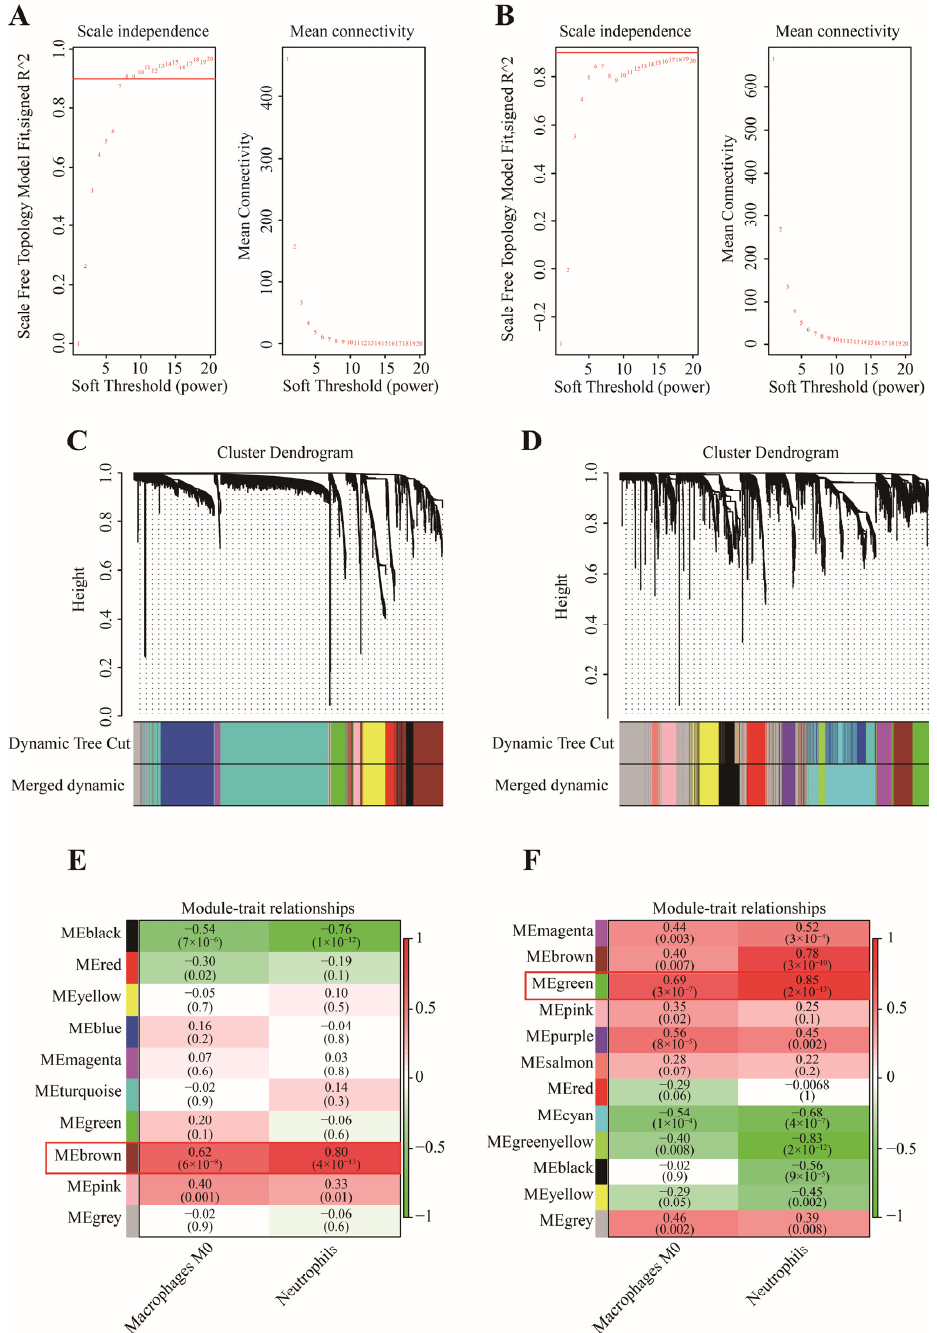
Figure 5. The selection of key modules associated with important immune cells. ( A ) The scale inde- pendence and mean connectivity in GSE152641. ( B ) The scale independence and mean connectivity in GSE171110. ( C ) The cluster dendrogram in GSE152641. ( D ) The cluster dendrogram in GSE171110. ( E ) The heatmap of correlation between modules and two important immune cells in GSE152641. ( F ) The heatmap of correlation between modules and two important immune cells in GSE171110.